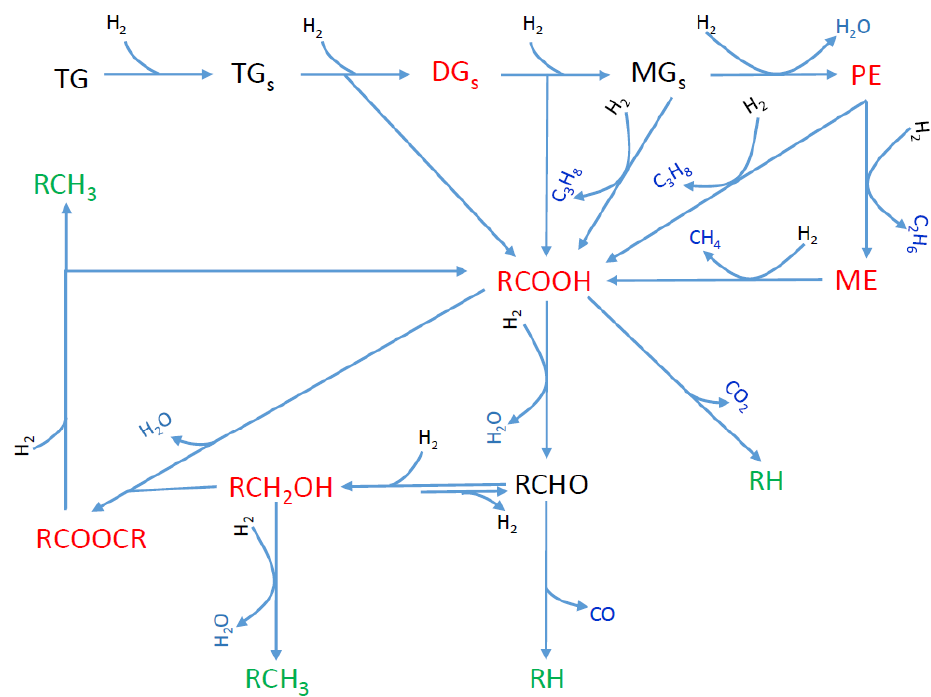
Figure 1. SDO reaction network. TG, TG S , DG S , MG S , PE and ME are the initial triglycerides, the saturated triglycerides, the saturated diglycerides, the saturated monoglycerides, the propyl-esters and the methyl-esters, respectively. The other molecules are represented by their chemical formulas [43]. (Molecules written in green, red and blue are final, intermediate and gas-phase products, respectively).